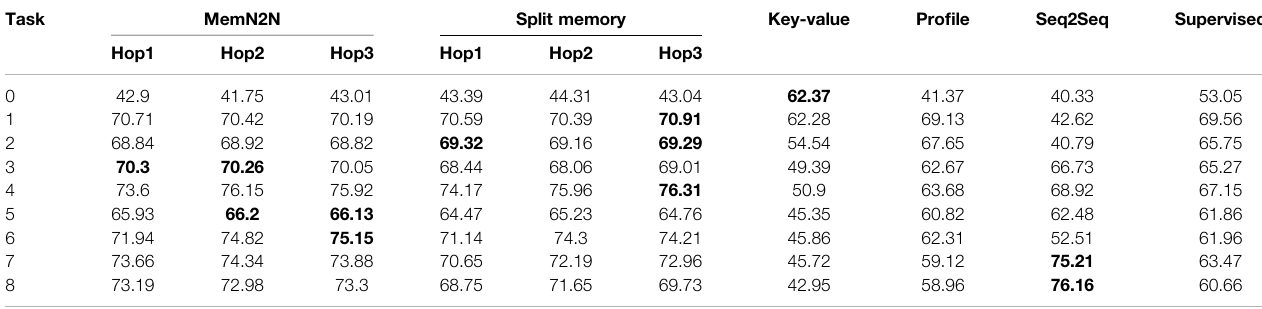
TABLE4| The test setresultsofthePersonalisedBaristawithPreferencesInformationDatasetwith1,000dialogues.Thebestperformingmethods(ormethodswithin0.1% ofbestperforming)aregiveninboldfortheper-responseaccuracymetric.TheresultsshowthatonaverageMemN2Nisthebestperformingmodel,however,Seq2Seq performs best for the task 8 (containing all tasks).